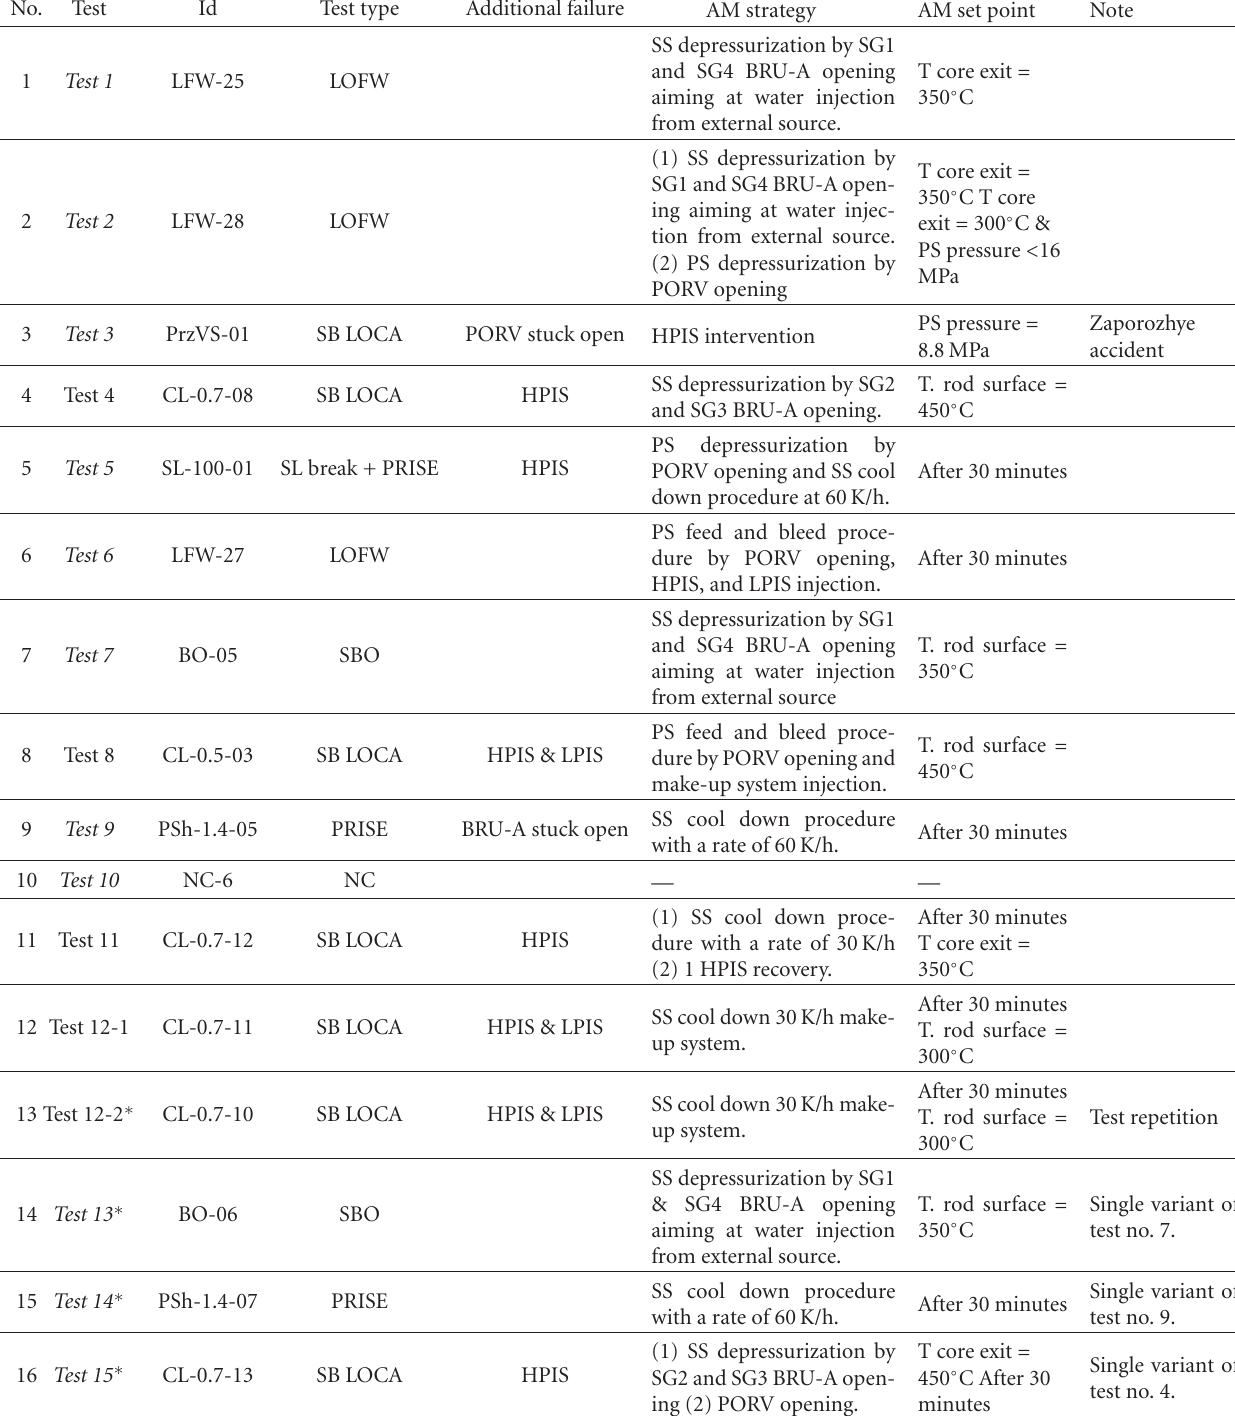
Table 1: Overview of the experimental activities, the use of the experimental data, and the connection with the AM.